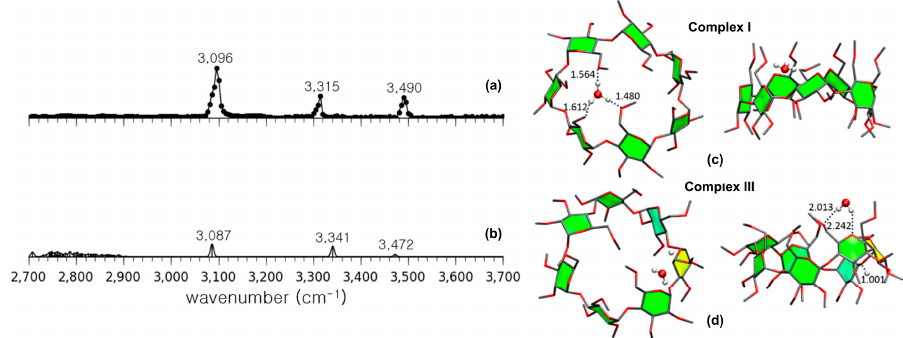
Figure12. ( a )TheexperimentallyobtainedIRphotodissociationspectrumofpermethylated β -CD–H 3 O + Figure 12. ( a ) The experimentally obtained IR photodissociation spectrum of permethylated β -CD– (Complex I) and ( b ) the calculated spectrum of permethylated β I-CD–H + / H 2 O (Complex III). H 3 O + (Complex І ) and ( b ) the calculated spectrum of permethylated βІ -CD–H + /H 2 O (Complex Ш ). ( c ) ( c ) Structures of Complex I and ( d ) Complex III. Reproduced from Reference [56] by permission of the PCCP Owner